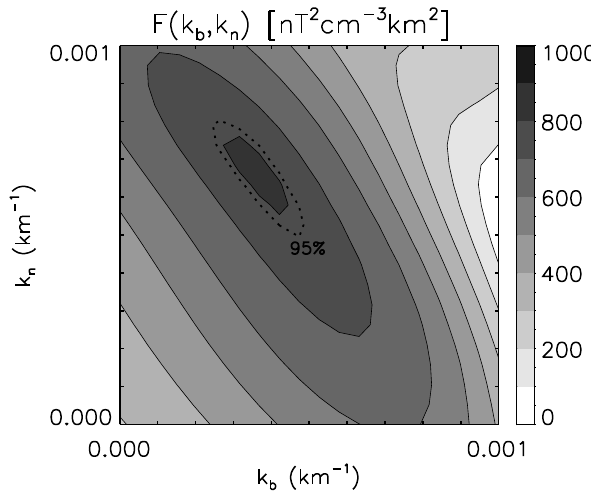
Fig. 7. Bispectrum using magnetic field and electron density data of Cluster in the foreshock under the resonance k b + k n , where k b and k n represent the wave number of the fluctuating magnetic field and electron density parallel to the mean magnetic field. The dotted line denotes the level of 95% confidence (Narita et al.,